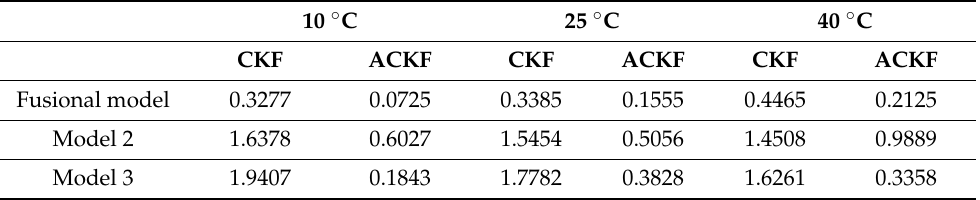
Figure 11. SOC estimation results for NMC battery by using: ( a ) CKF at 10 °C. ( b ) ACKF at 10 °C. ( c ) CKF at 25 °C. ( d ) ACKF at 25 °C. ( e ) CKF at 40 °C. ( f ) ACKF at 40 °C. Table 7. RMSE of SOC estimation for NMC battery